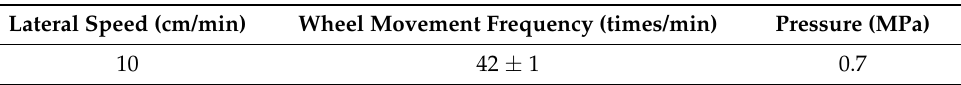
Table 9. Operating parameters of abrasion tester.